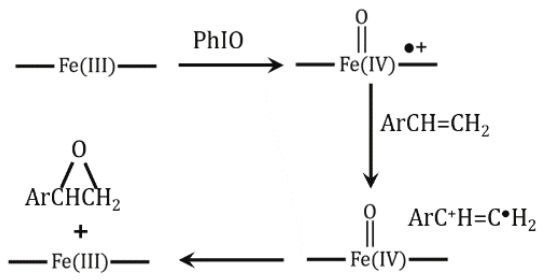
Figure 2: Schematic representation of Fe(III) porphyrins immobilised on LDH clay, intercalated with glycine [59]. Reprinted with permission from Ref. [59]. Copyright © 2005,